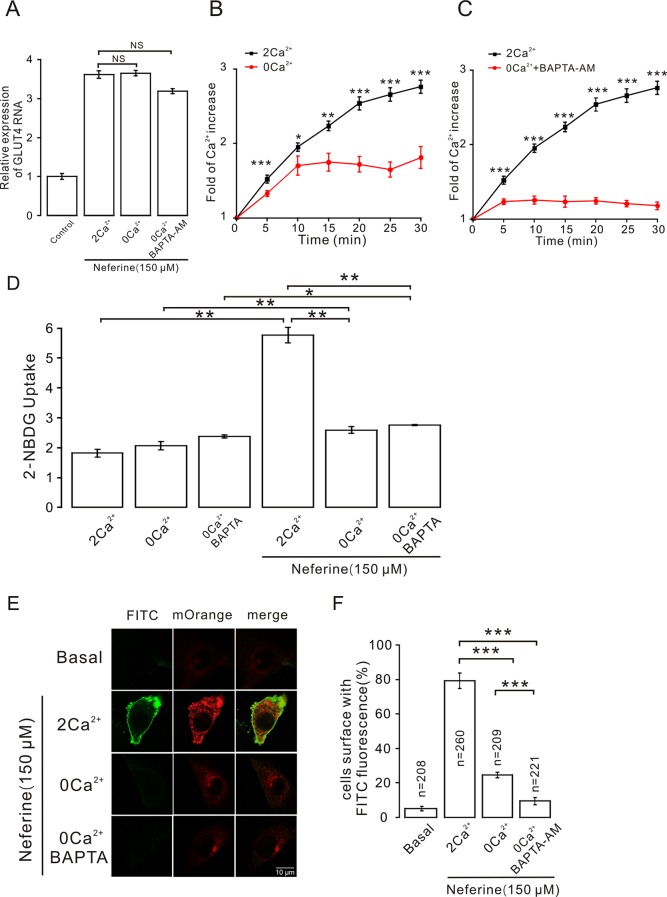
Intracellular calcium chelator BAPTA-AM does not inhibit neferine-induced GLUT4 expression but inhibits GLUT4 fusion with the plasma membrane and glucose uptake enhanced by neferine. (A) Treatment with 150 µM neferine in L6 cells under the condition of 0 mM extracellular Ca2+, 2 mM extracellular Ca2+, and 0 mM extracellular Ca2+ + 10 μM BAPTA-AM yields no significant differences in GLUT4 expression. (B) Treatment with 150 μM neferine in L6 cells with 0 mM extracellular Ca2+ showed significant inhibition of intracellular Ca2+ concentration. (C) After treatment with 0 mM extracellular Ca2+ + 10 μM BAPTA-AM, the increase in intracellular Ca2+ concentration by 150 μM neferine was inhibited. (D) Treatment with 2 mM extracellular Ca2+, 0 mM extracellular Ca2+, and 0 mM extracellular Ca2+ + 10 μM BAPTA-AM yields no significant differences in intracellular glucose uptake. Treatment with 2 mM extracellular Ca2+ after neferine treatment significantly increases glucose uptake in L6 cells. Treatment with 0 mM extracellular Ca2+ and 0 mM extracellular Ca2+ +10 μM BAPTA-AM and neferine inhibit glucose uptake in L6 cells. (E) Treatment of myc-GLUT4-mOrange L6 cells with neferine under the displayed conditions showing laser confocal microscopy detection of GLUT4-mOrange red fluorescence in L6 cells and FITC green fluorescence on cell membranes. Scale bar: 10 μm. (F) Activated FITC fluorescence cell count and quantitation in L6 cells. NS P > 0.05; *P < 0.05; **P < 0.01; ***P < 0.001.